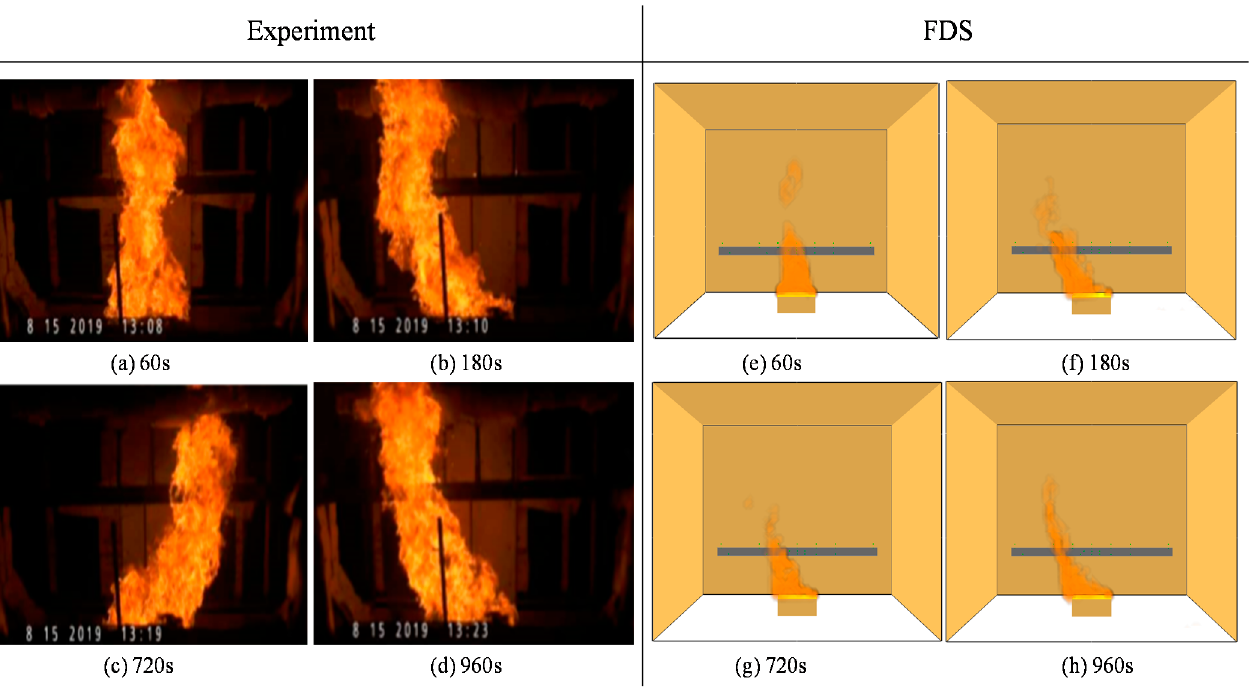
Figure 11. Experimental and computational fluid dynamics scenes of flame movement. FDS: Fire Dynamics Simulator.